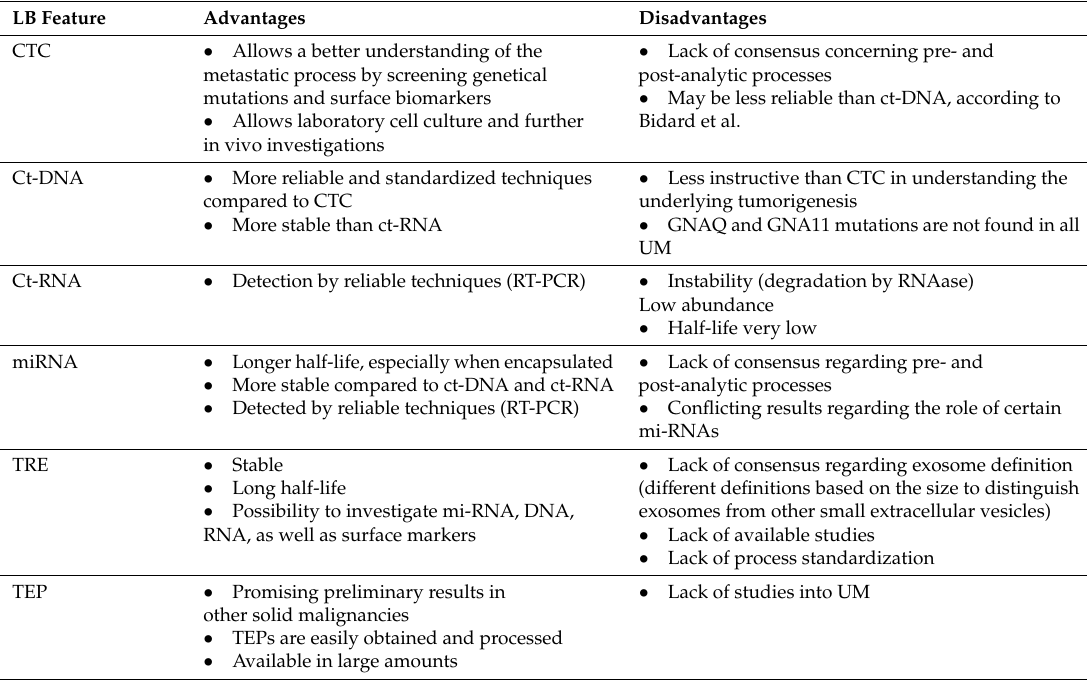
Table 4. Advantages and limitations of liquid biopsies for uveal